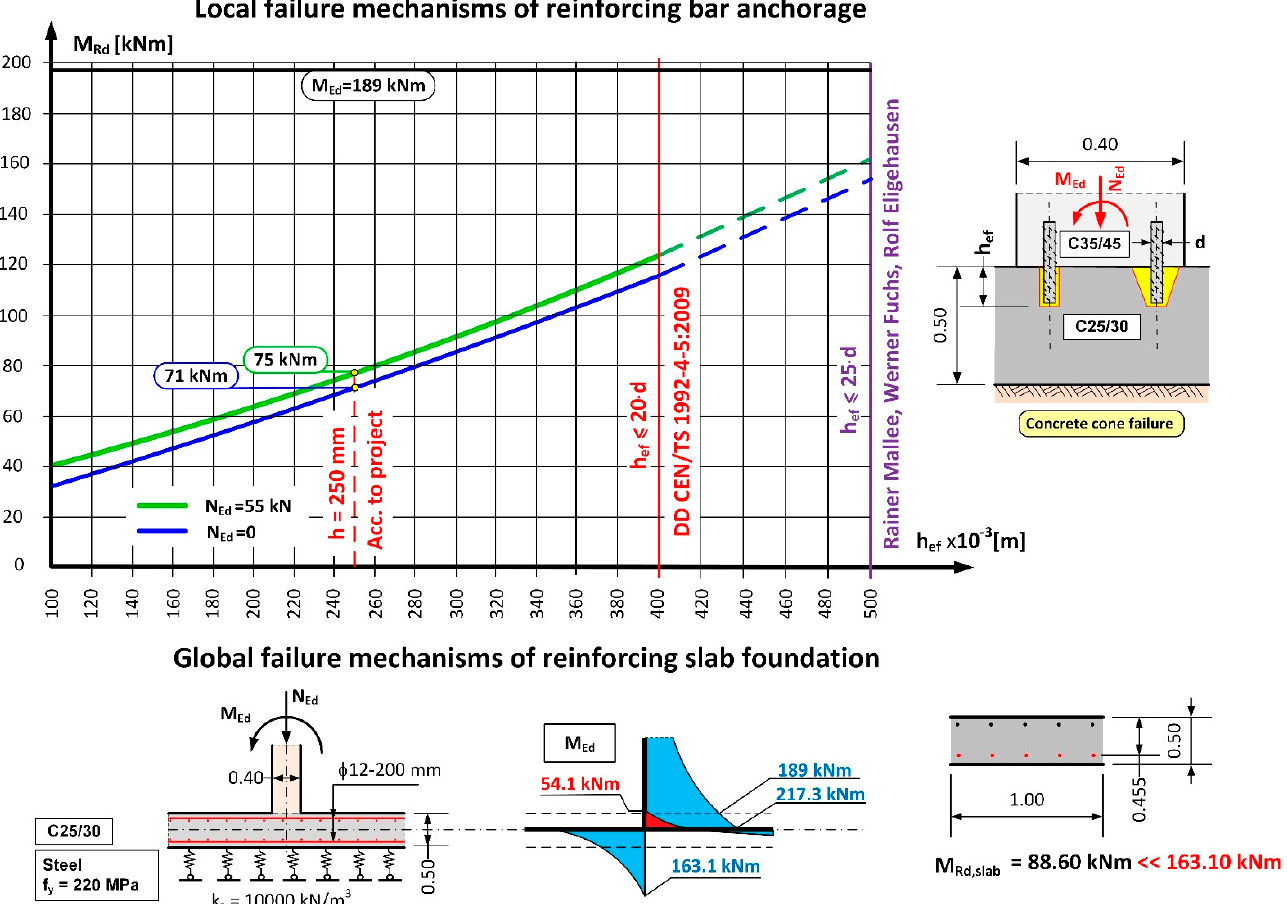
Figure 15. Anchorage capacity of the wall and foundation slab connection from the condition of the anchorage length of the bars [17,18] and the bending resistance of the foundation.